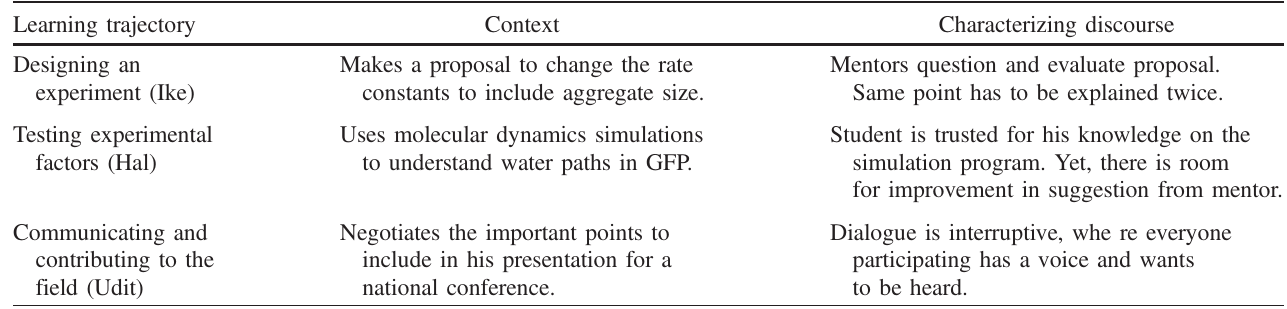
TABLE I. Competencies developed during learning trajectory. Learning trajectory Context Characterizing discourse Designing an Makes a proposal to change the rate experiment (Ike) constants to include aggregate